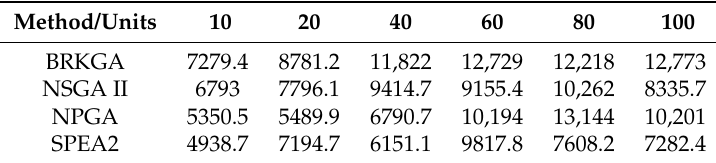
Table 9. Spacing average measures over 10 optimization runs.